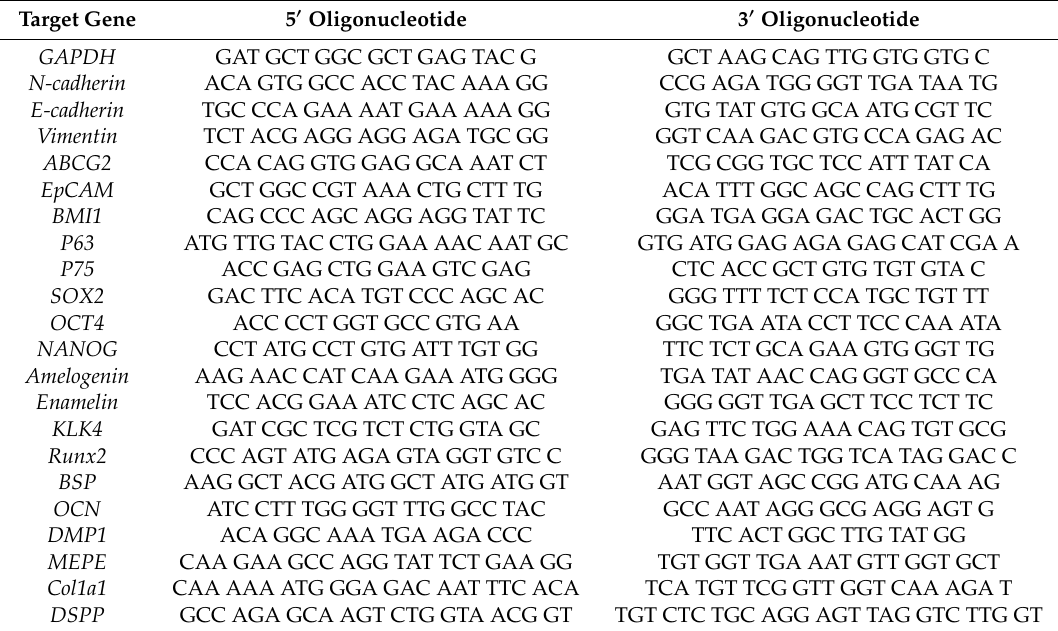
Table 2. Sequences of primers used for indicated target